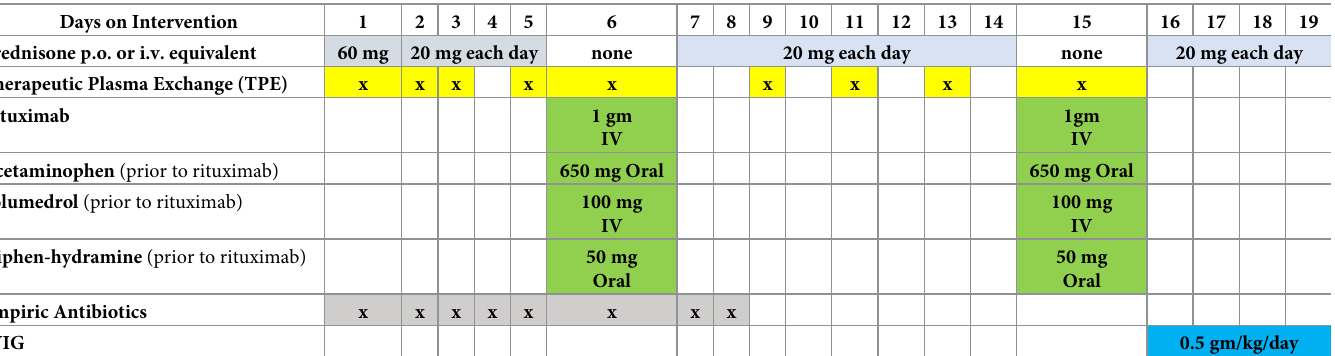
Table 1. Triple-modality autoantibody reduction